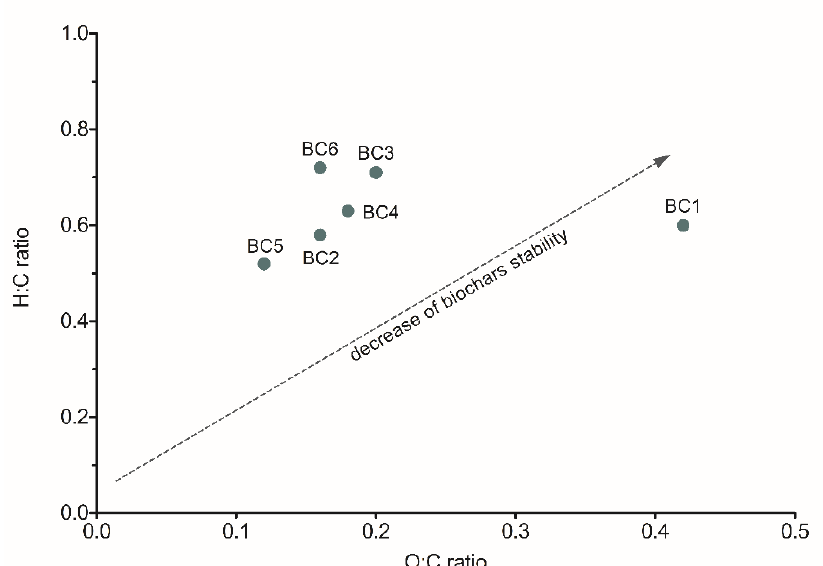
Figure 1. Van Krevelen’s diagram for examined biochars. The arrow indicates direction of changes in expected biochar’s stability.